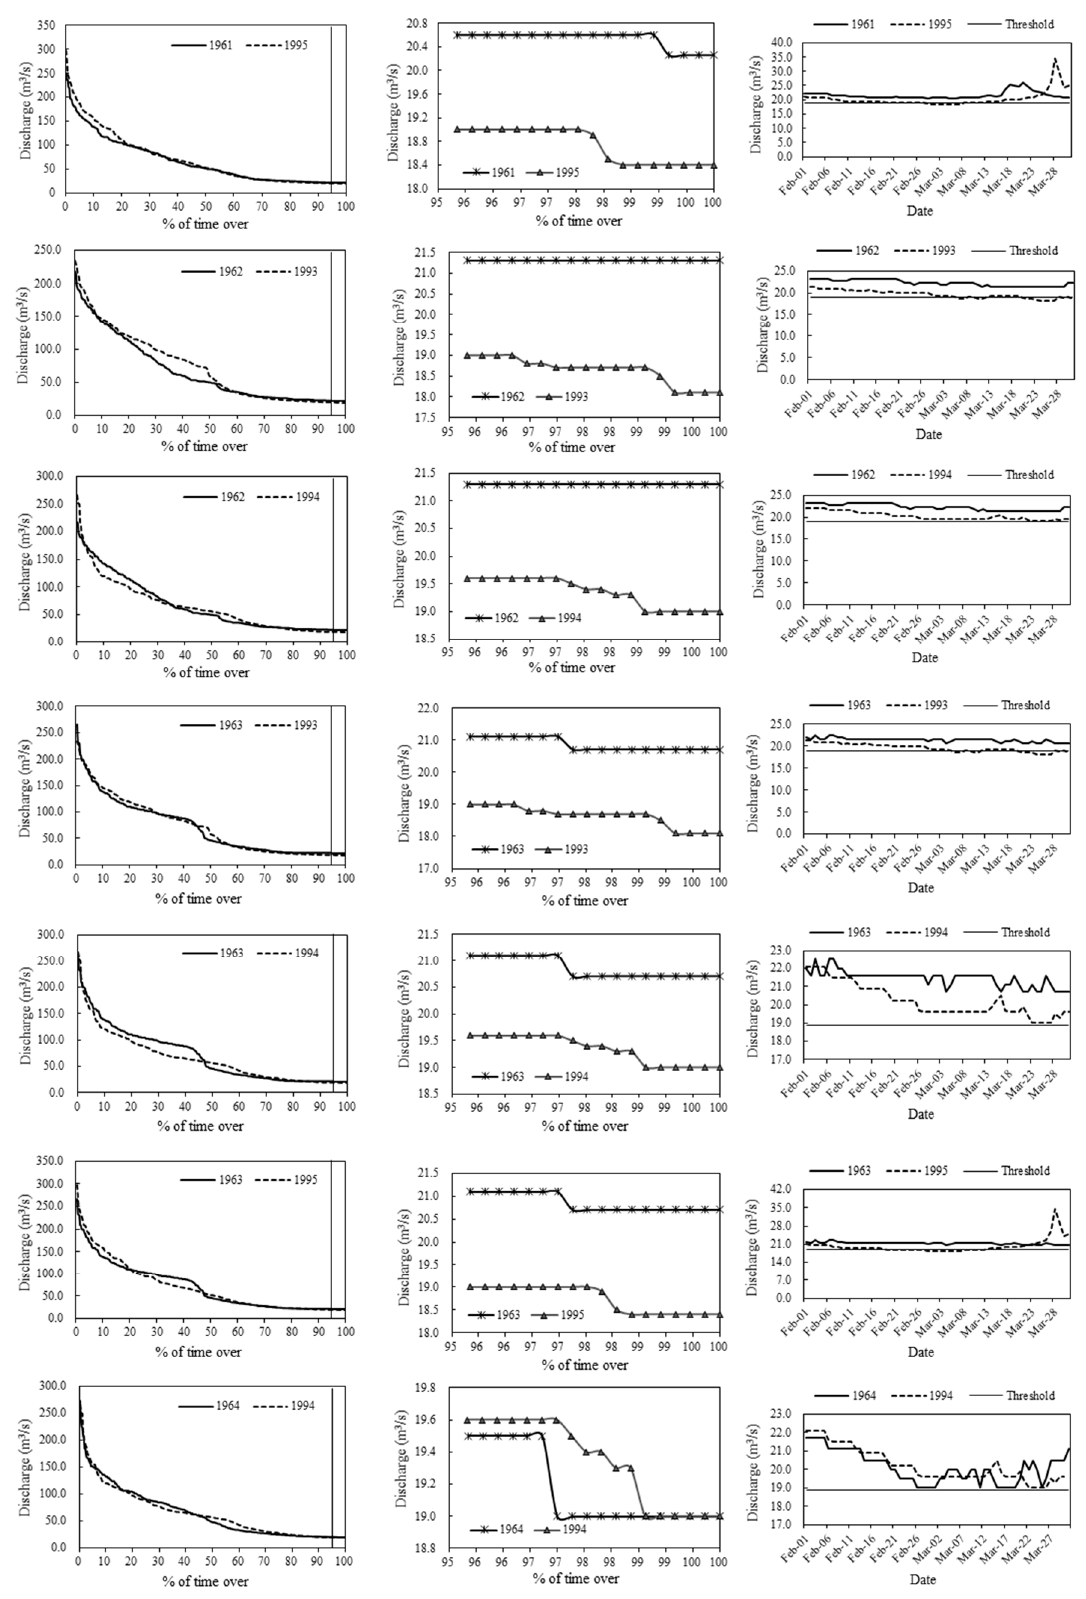
Figure A3. Flow duration curves for all selected pairs in Phase 1 and Phase 4.